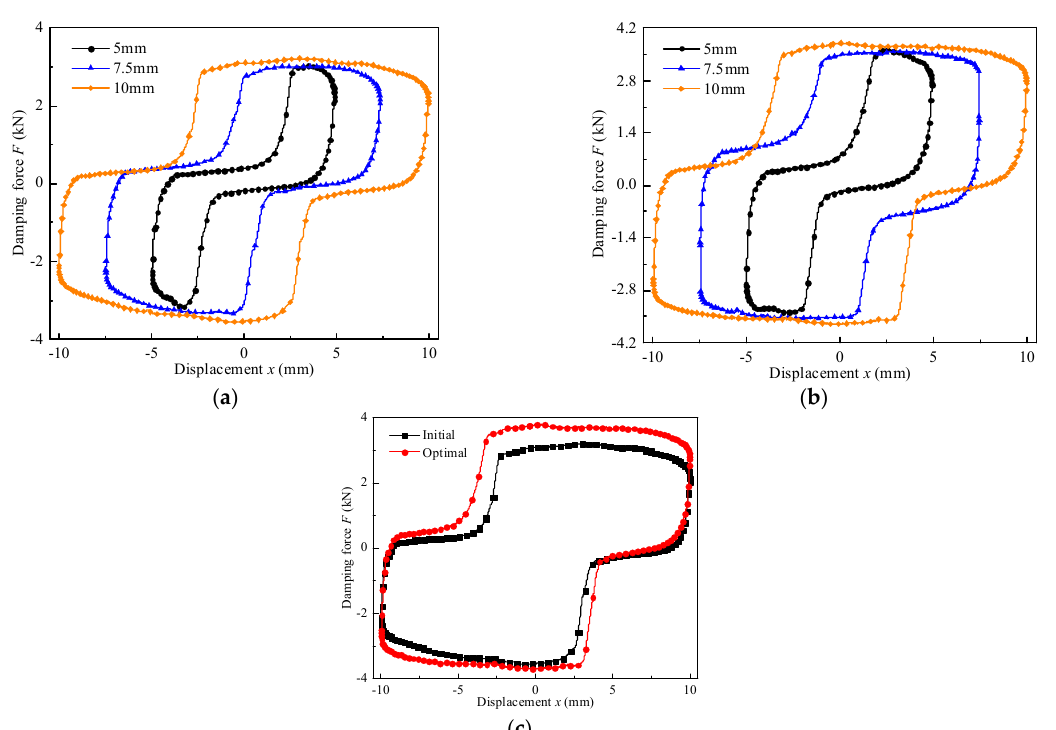
Figure 25. Damping force versus displacement at constant current and frequency: ( a ) initial, ( b ) optimal, ( c ) comparison of the initial and optimal damping